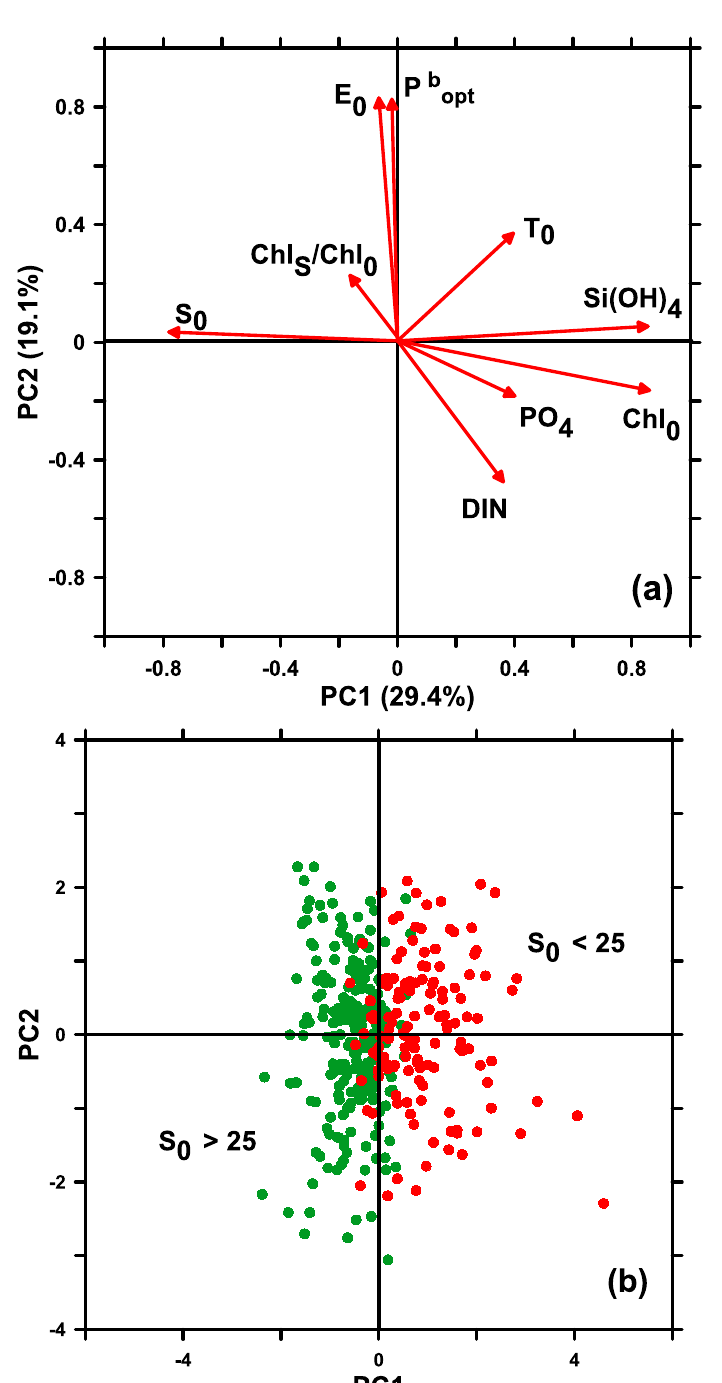
Figure 4. Graphical representation of the results of the principal component analysis (PCA). ( a ) Correlations on the factorial plane formed with the two first principal components (PC1 and PC2). The values at the axis designate the PC1 and PC2 contribution to the total variance. The values of the optimal assimilation number (P bopt ), surface chlorophyll a concentration (Chl 0 ), subsurface PAR (E 0 ), surface water temperature (T 0 ), surface salinity (S 0 ), phosphate (PO 4 ), dissolved silicon (Si(OH) 4 ), dissolved inorganic nitrogen (DIN), and the ratio of chlorophyll a concentration of small (<3 μ m) to total surface phytoplankton (Chl s /Chl 0 ) are presented. ( b ) Projection of the individual samples collected in the brackish (S 0 < 25) (red colour) and oceanic (S 0 > 25) (green colour) waters of the Siberian Seas on the factorial plane.